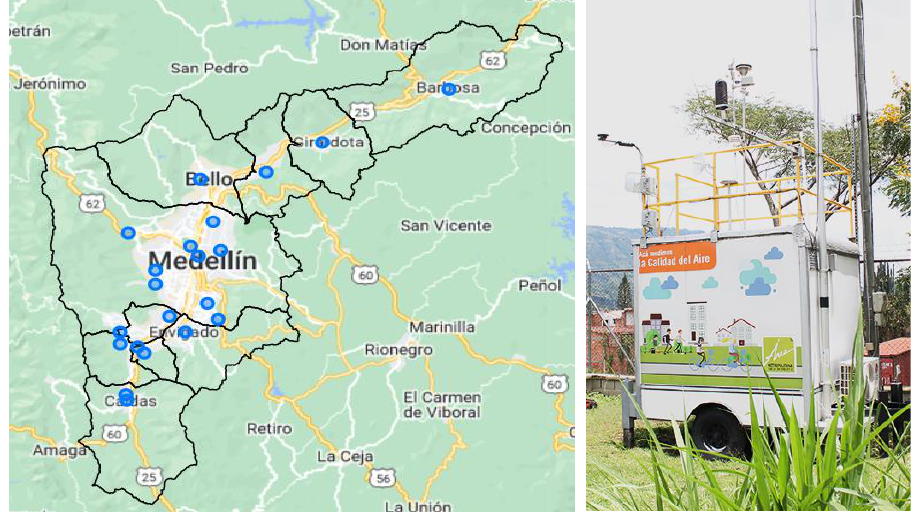
Figure 3. Location of PM2.5 concentration monitoring stations around Valle de Aburrá [15].